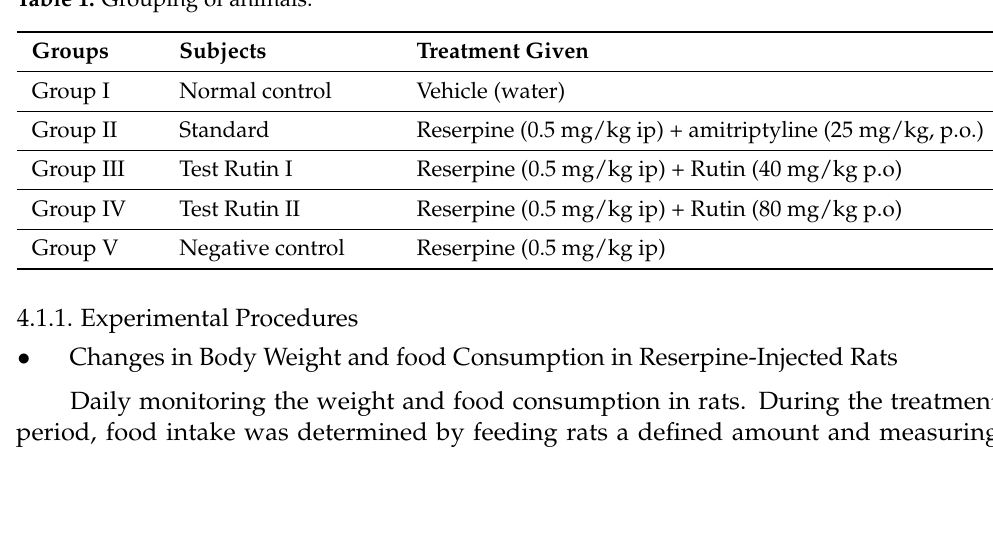
Table 1. Grouping of